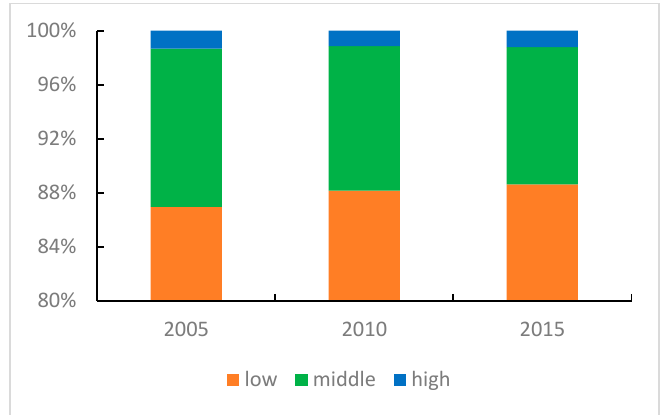
Figure 15. Classification of soil conservation services in the Loess Plateau Ecological Screen from 2005 to 2015.